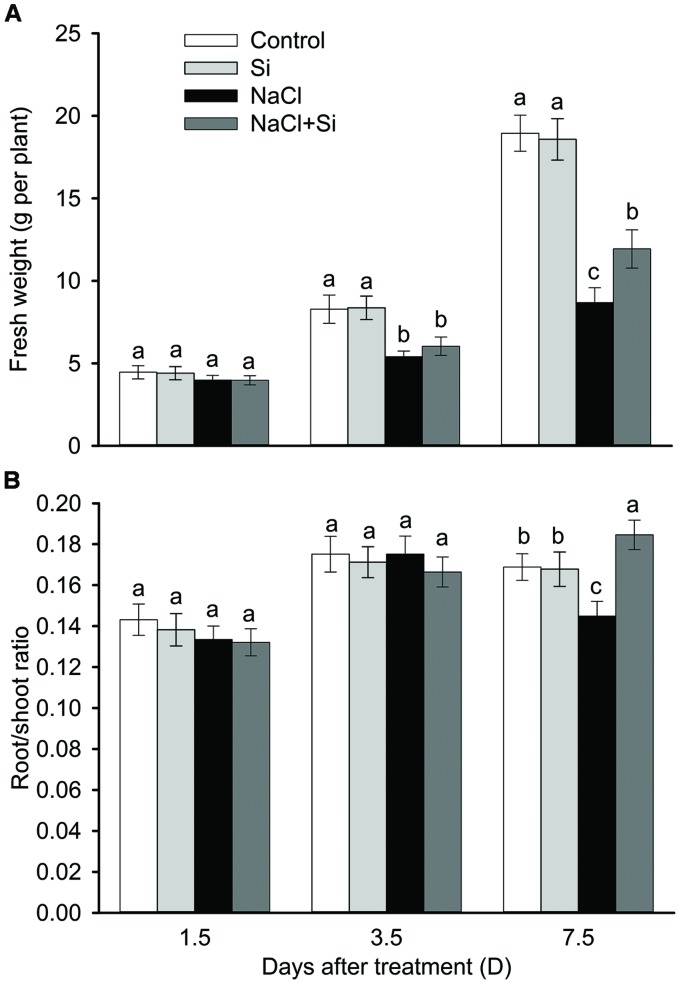
Effects of silicon (0.83 mM) and salt stress (65 mM) on the fresh weight (A) and root/shoot ratio (B) of cucumber seedlings. All parameters were measured after 1.5, 3.5, and 7.5 days of salt treatment. Vertical bars represent the standard deviations (n = 3). Different letters at the same time point represent significant differences (p < 0.05) between the treatments.